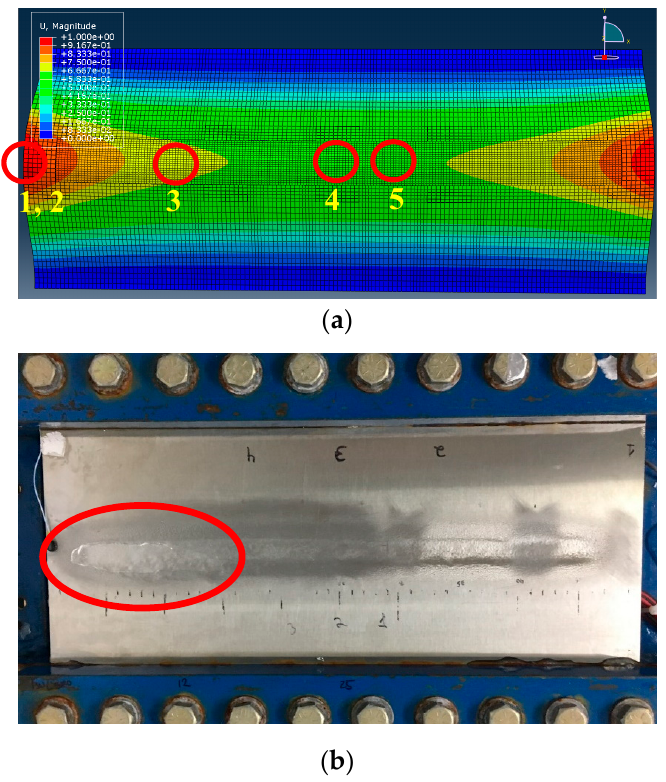
Figure 10. Resonant mode 1 from frequency analysis ( a ) and delamination of the ice layer during sweep test with all piezoelectric actuators activated in phase from 187 Hz to 197 Hz in 10 s ( b ). Table 6. Results obtained for delamination tests.